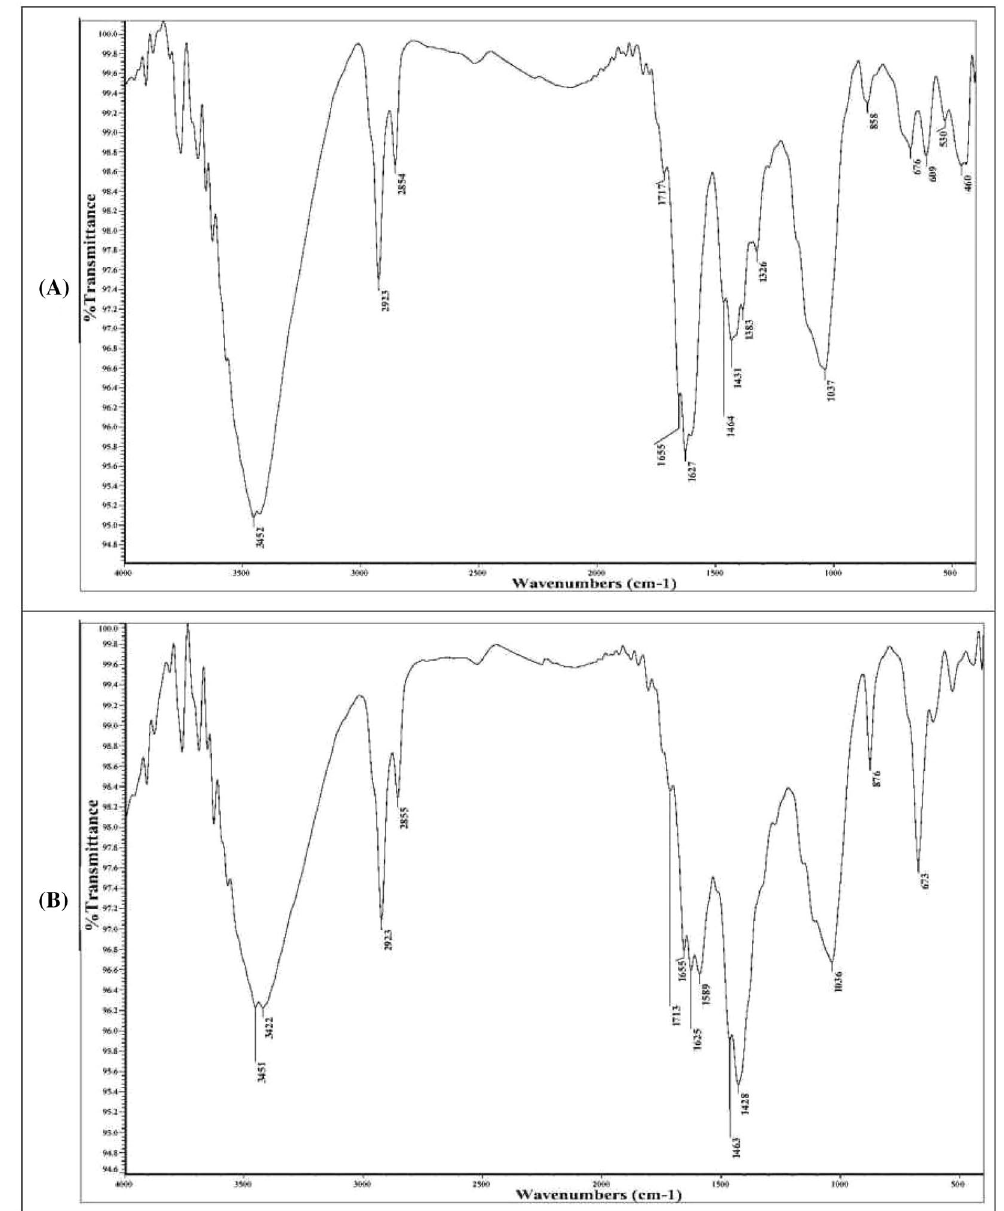
Figure 6. FTIR spectral analysis for Sargassum latifolium biomass before ( A ) and after ( B ) dual biosorption of Cobalt(II) and MB